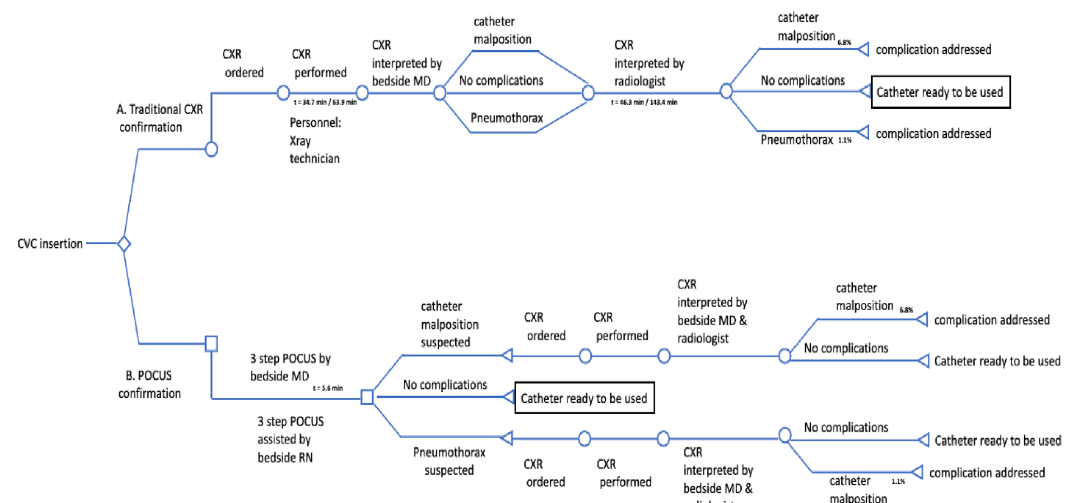
Figure 2. A decision tree model comparing protocol A (traditional X-ray confirmation) vs protocol B (POCUS-guided confirmation).